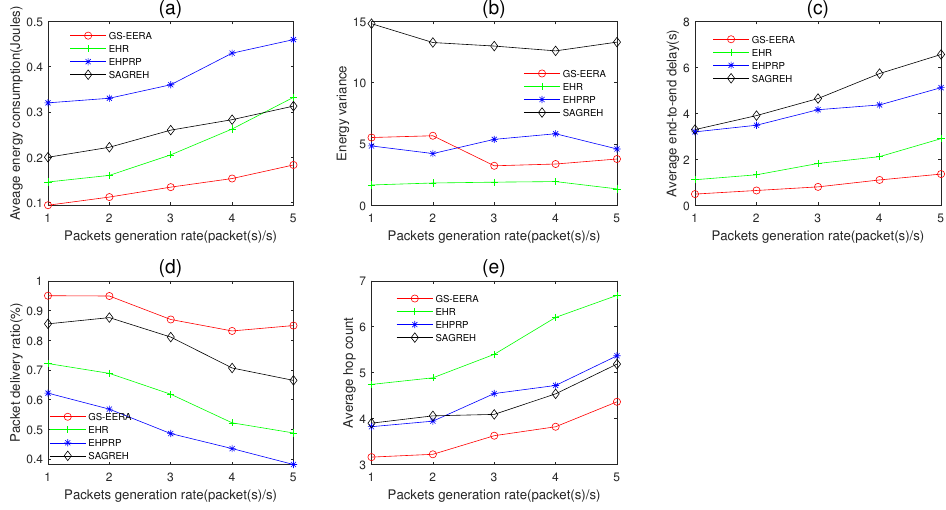
Figure 14. The impact of packets generation rate on ( a ) average energy consumption, ( b ) energy variance, ( c ) average end-to-end delay, ( d ) packet delivery ratio and ( e ) average hop count. Overall, as the packets generation rate PGR increases, energy consumption, end-to- end delay and hop count increase and packet delivery ratio decreases (not